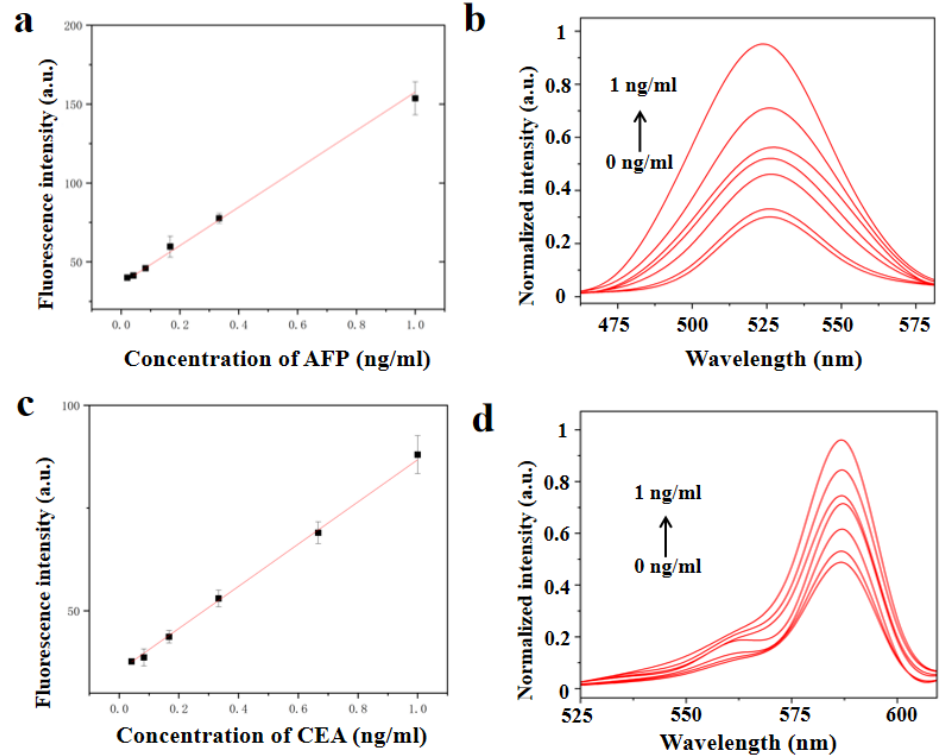
Figure 4. ( a ) calibration chart of AFP concentration and fluorescence intensity. ( b ) the variation of the Signal response with the concentration of AFP. ( c ) calibration chart of CEA concentration and fluorescence intensity. ( d ) the variation of the Signal response with the concentration of CEA. The error line represents the standard deviation of the three repeated measurements.